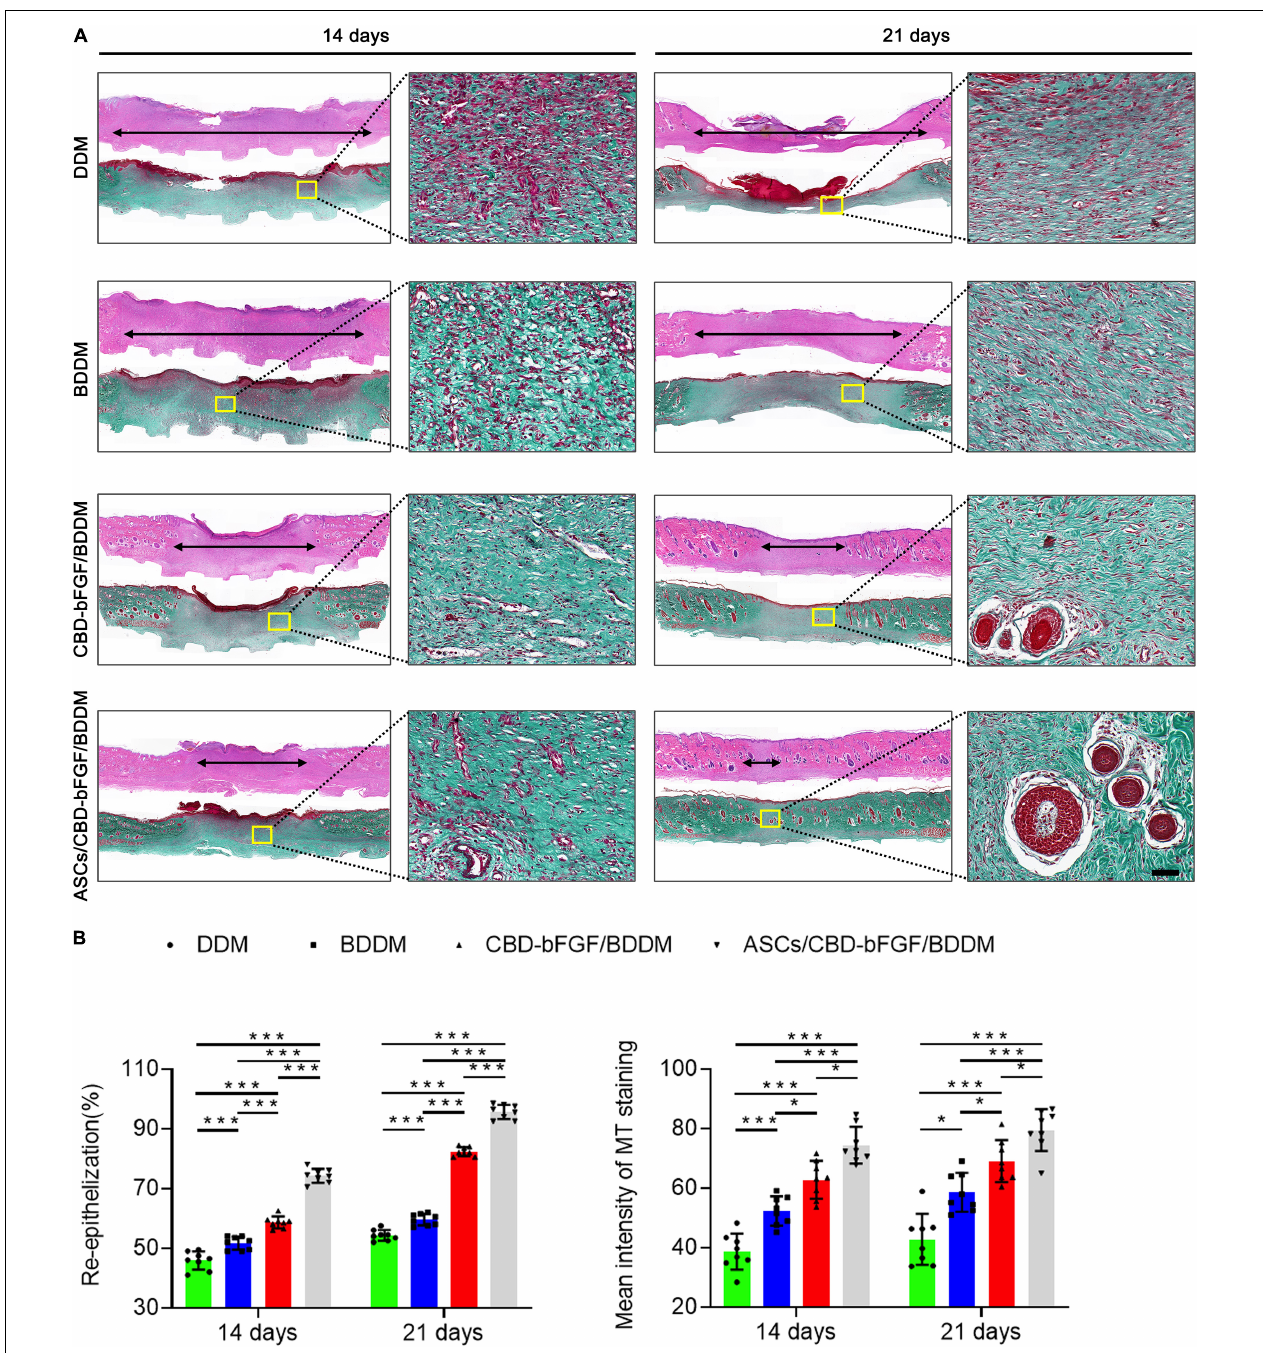
FIGURE 8 | (A) H&E and Masson’s trichrome (MT) staining of wound sections in the decellularized dermal matrix (DDM), book-shaped decellularized dermal matrix (BDDM), collagen-binding domain–basic fibroblast growth factor (CBD–bFGF)/BDDM, or adipose-derived stromal cells (ASCs)/CBD–bFGF/BDDM groups at 14 or 21 days after the operation. The double-headed black arrows indicate the edges of the scars. Bar = 100 µ m. (B) Quantitative analysis of the re-epithelialization extent and the mean intensity of MT staining in the histological sections of the DDM, BDDM, CBD–bFGF/BDDM, or ASCs/CBD–bFGF/BDDM groups. Data are shown as means ± standard deviation (* P < 0.05, ** P < 0.01, and *** P < 0.001).